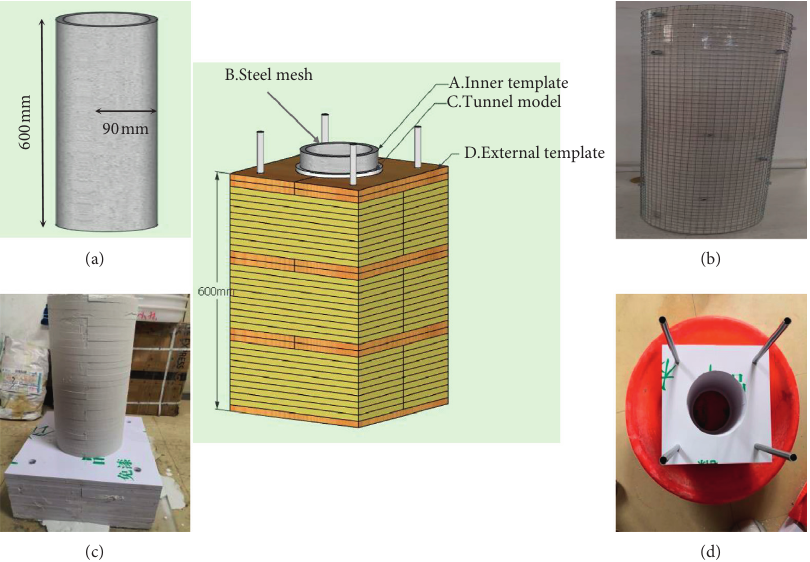
Figure 3: Model of tunnel lining structure.